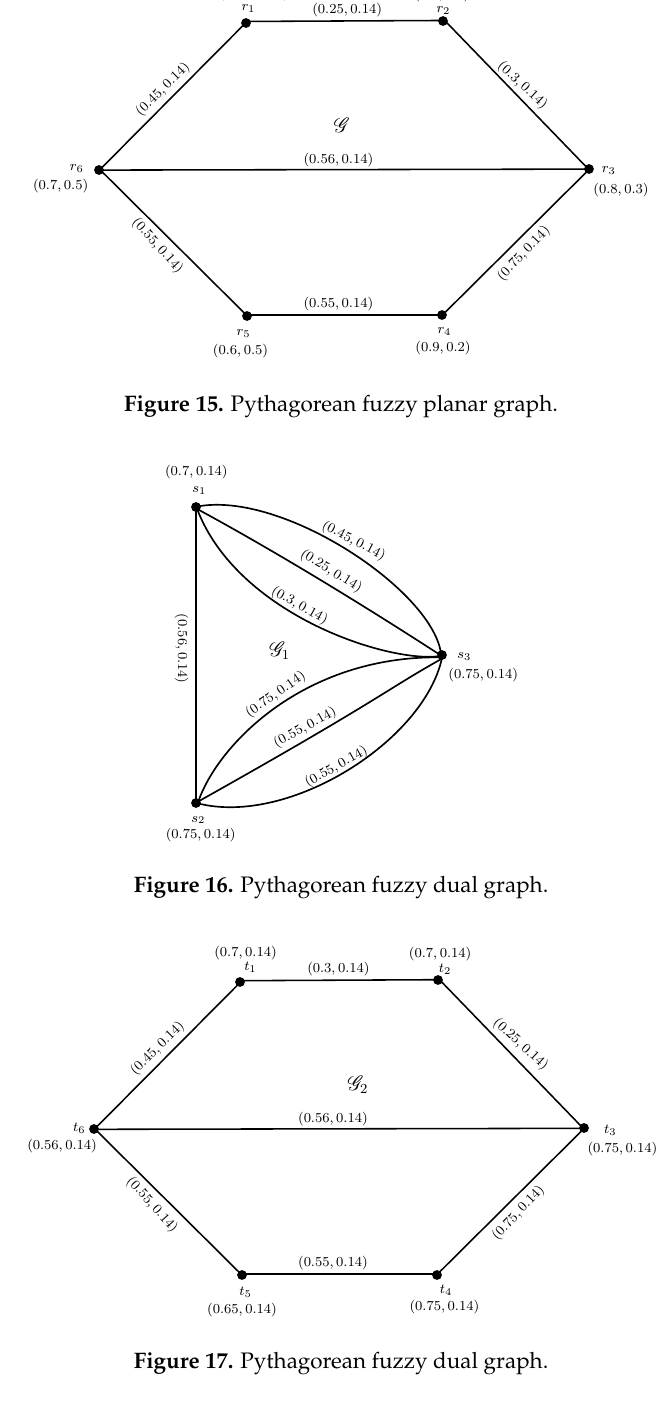
Figure 6.6: Pythagorean fuzzy dual graph Where 528